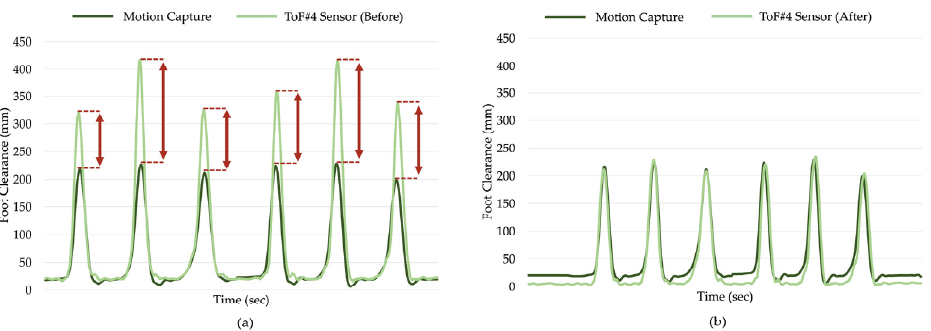
Figure 7. A sample plot of a 6-step normal walking trial of mocap and ToF #4 signals ( a ) before angle and offset compensation and ( b ) after angle and offset compensation. The red arrows in Figure 7a illustrate the difference in peak values measured by both systems.